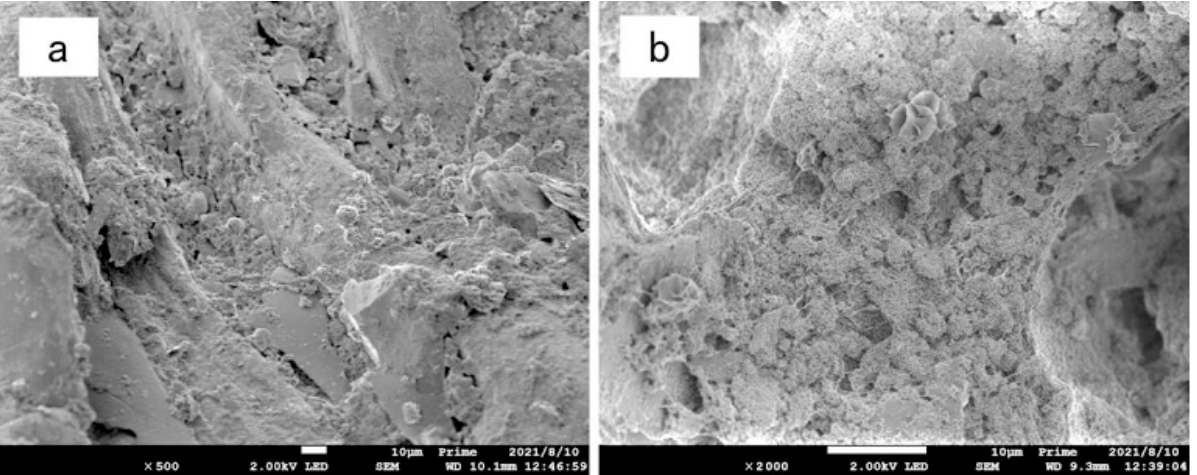
Figure 11. Electron microscopic picture of 12%PVA + 4% active magnesium oxide composite im- provement. ( a ) 500-fold magnified ( b ) 2000-fold magnified